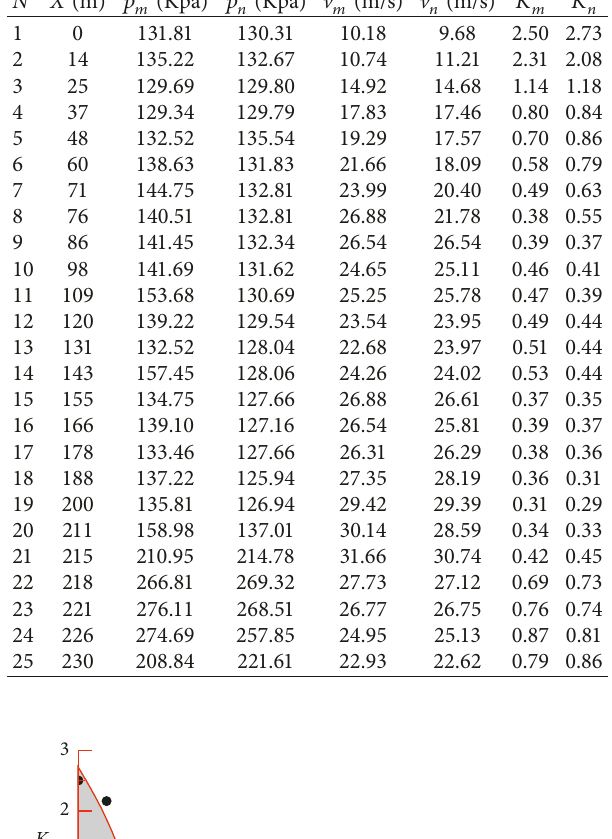
Table 1: Cavitation number distribution on the centerline of the soleplate.